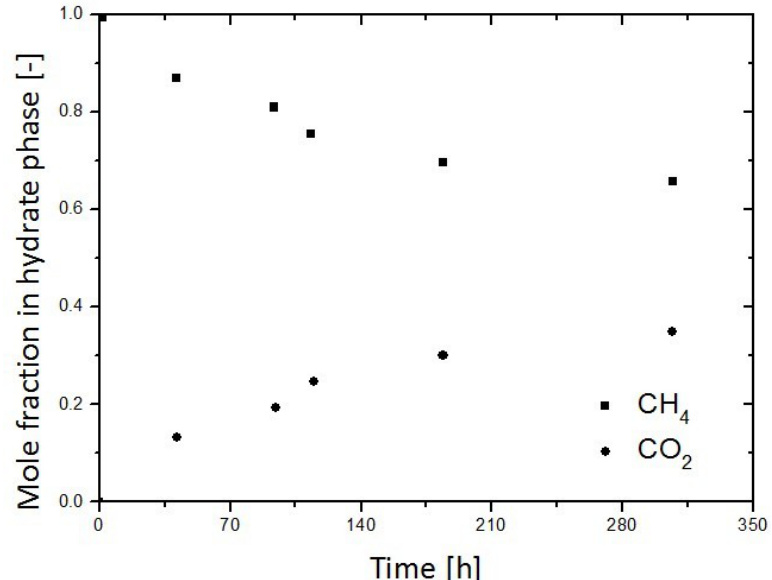
and CO in the hydrate phase as a function of 4 2